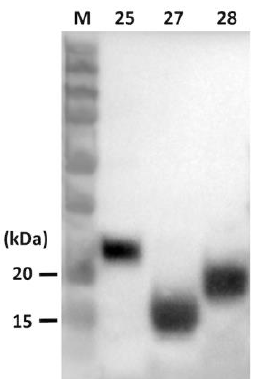
Figure 3. Western blotting analysis of the expression of porcine CCL25 (lane 25), CCL27 (lane 27), and CCL28 (lane 28) proteins. The recombinant CC chemokine proteins were detected by anti-V5 antibodies (1:5000 dilution) as the primary antibody and alkaline peroxidase conjugated goat anti-mouse IgG (1:10,000 dilution) as the secondary antibody. The polyvinylidene difluoride ( PVDF ) membranes were developed by the Clarity™ Western enhanced chemiluminescence ( ECL ) blotting substrates (Bio- Rad) and visualized by ChemiDoc™ Imaging Systems (Bio -Rad).